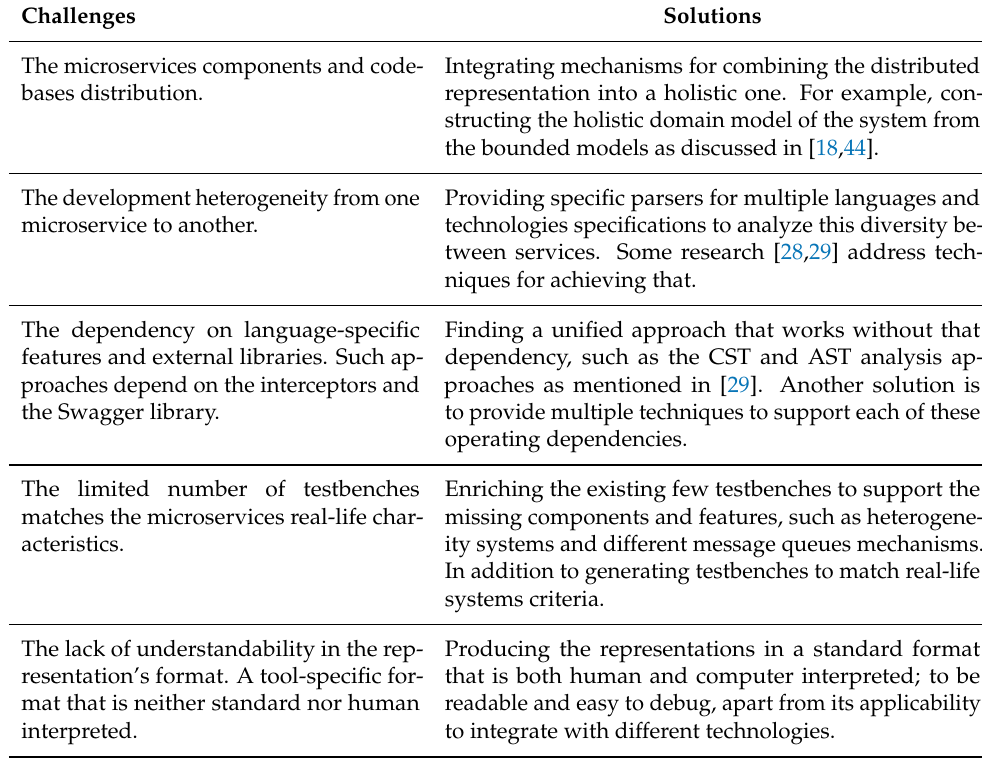
Table 2. Architecture reconstruction challenges and